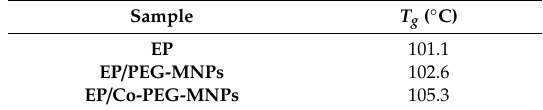
Table 4. T g of fully cured neat epoxy and its nanocomposites at β of 10 ◦ C min − 1 .